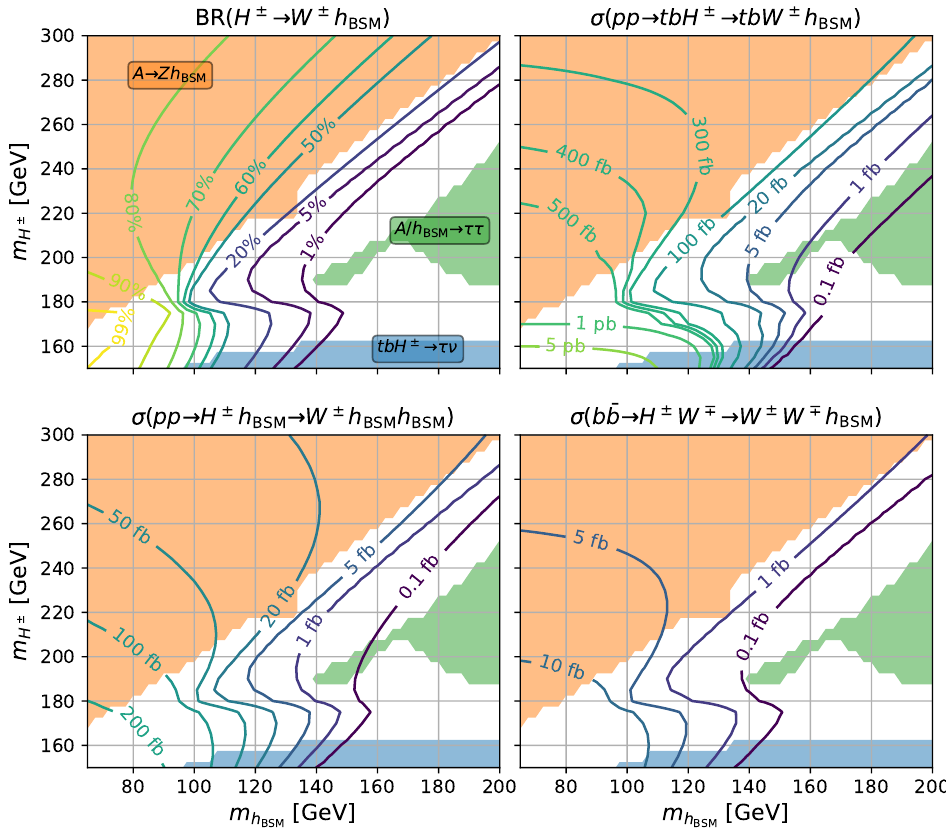
) parameter plane. The colored , m h H ± BSM ( top-right ), pp → H ± h ± h BSM BSM → W BSM h BSM ( bottom-right ) channels in the remaining panels. BSM